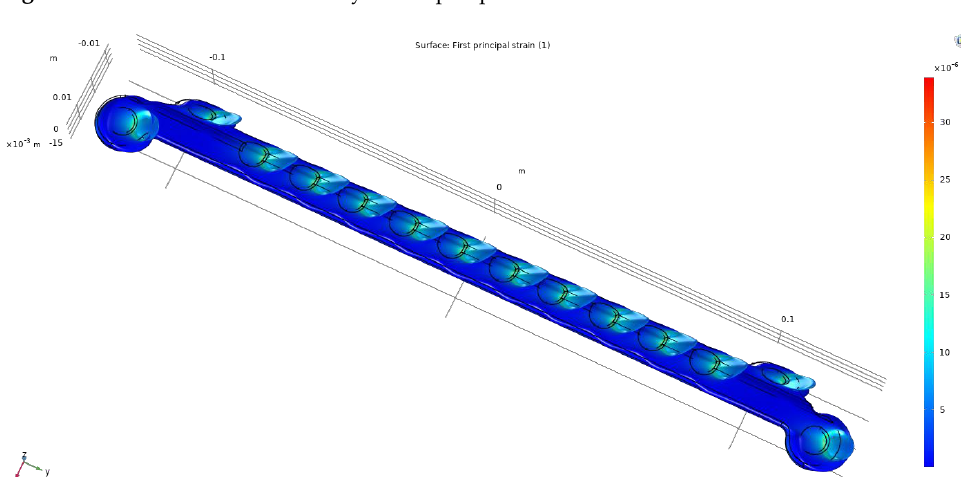
Figure 25. Von Mises stress of newly developed plate bent for 50°.